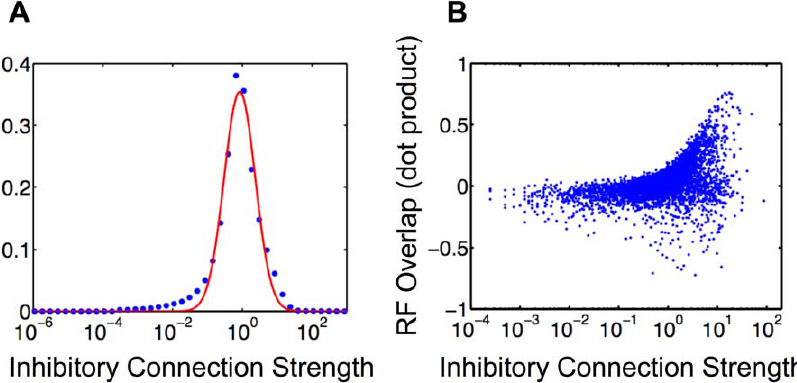
Figure 6. Connectivity learned by SAILnet allows for further experimental tests of the model. (A) Probability Density Function (PDF) of the logarithms of the inhibitory connection strengths (non-zero elements of the matrix W im ) learned by a 1536 unit SAILnet trained on 16 | 16 pixel patches drawn from whitened natural images. The measured values (blue points) are well-described by a Gaussian distribution (solid line), which accounts for R 2 ~ 98% of the variance in the dataset. This indicates that the data are approximately lognormally distributed. Note that there are some systematic deviations between the Gaussian best fit and the true distribution, particularly on the low-connection strength tail, similar to what has been observed for excitatory connections within V1 [18]. This plot was created using the binning procedure of Hroma´dka and colleagues [20]. The histogram was normalized to have unit area under the curve. (B) The strengths of the inhibitory connections between pairs of cells are correlated with the overlap between those cells’ receptive fields: cells with significantly overlapping RFs tend to have strong mutual inhibition. Data shown in panel (B) are for 5,000 randomly selected pairs of cells. Pairs of cells with significantly negatively overlapping RFs tend not to have inhibitory connections between them, hence the apparent asymmetry in the RF overlap distribution obtained by marginalizing over connection strengths in panel (B).